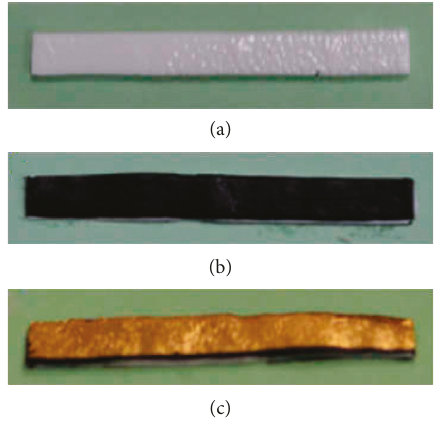
Figure 4: Fabrication process of the soft actuator: (a) ILG; (b) the activated carbon layer is affixed; (c) the gold foil layer is affixed.